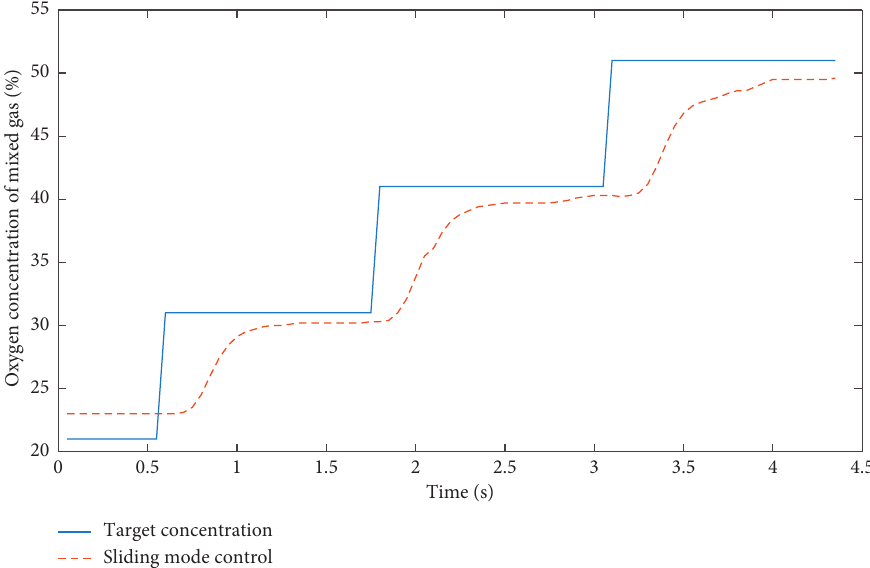
Figure 11: Comparison of mixed gas oxygen concentration under sliding mode control.